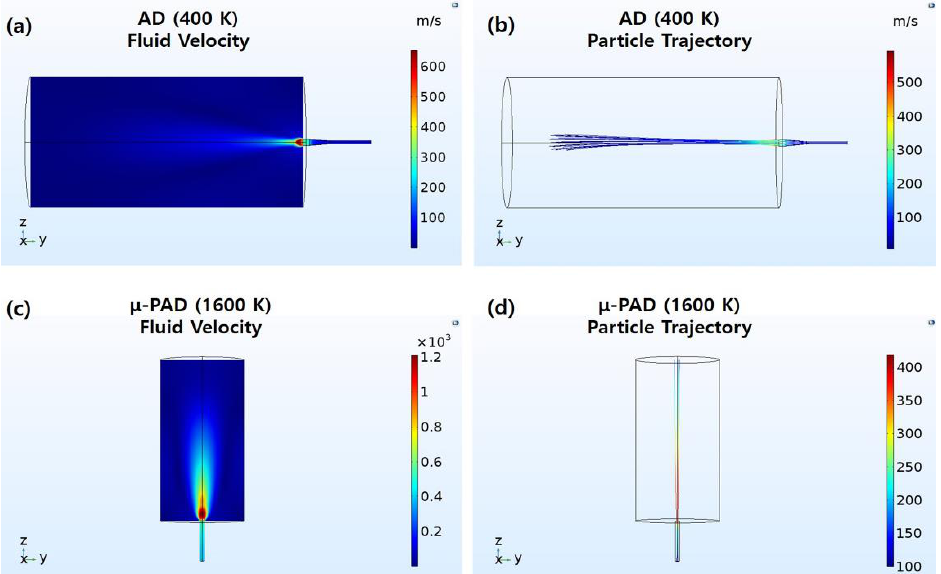
Figure 7. Velocity simulation of fluid and particles of AD and μ -PAD using 3D COMSOL Multiphysics: ( a ) fluid velocity of AD, ( b ) particle trajectory and velocity of AD, ( c ) fluid velocity of μ -PAD, and ( d ) particle trajectory and velocity of μ -PAD.